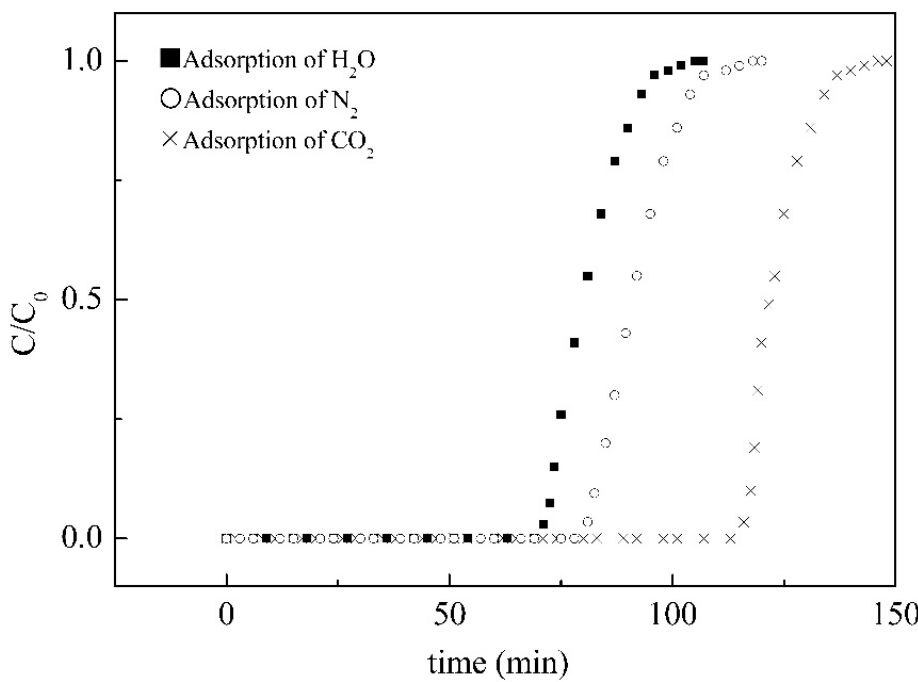
Figure 8. Breakthrough curves for the adsorption of a single component by the composite membrane in the adsorption system.